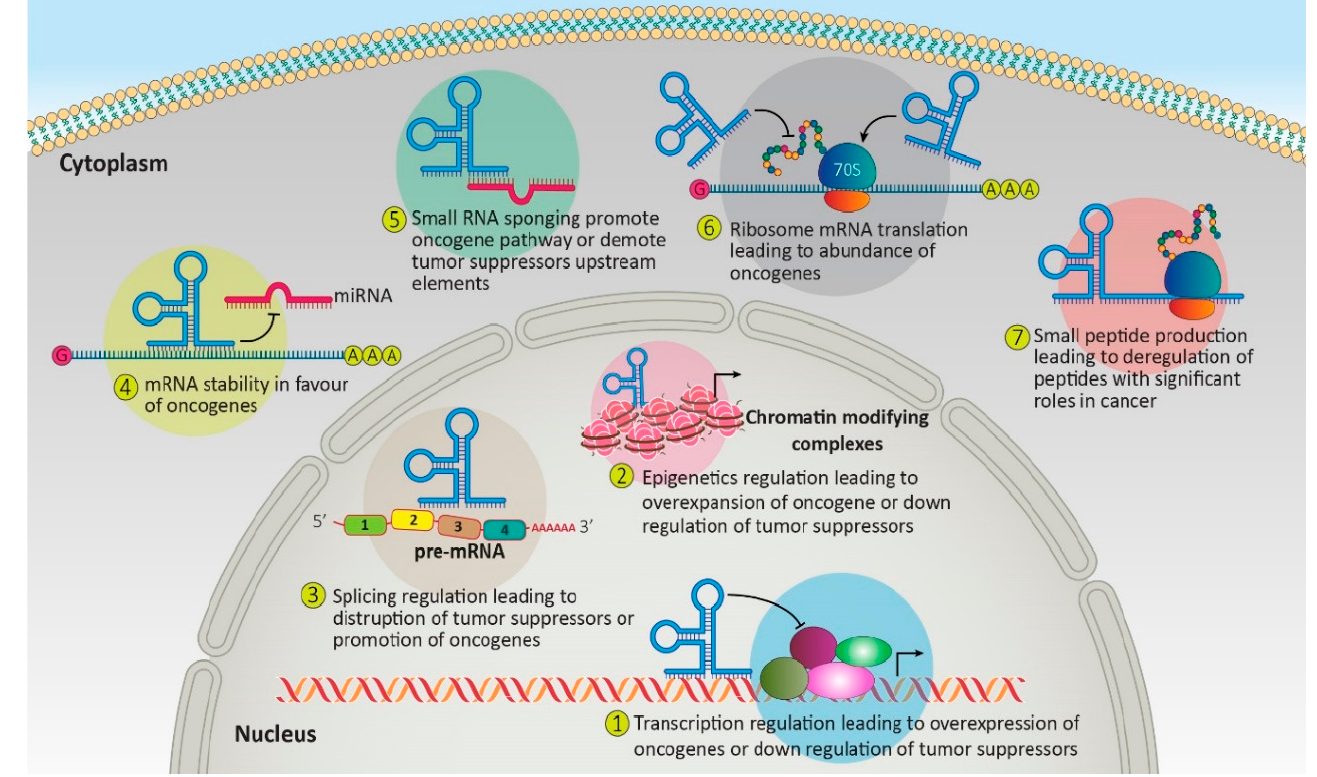
Figure 2. The proposed mechanism of action for non-coding RNAs to regulate oncogenes and tumor suppressor’s network. Table 1. Summary of the proposed mechanism of non-coding RNAs in leukemia.